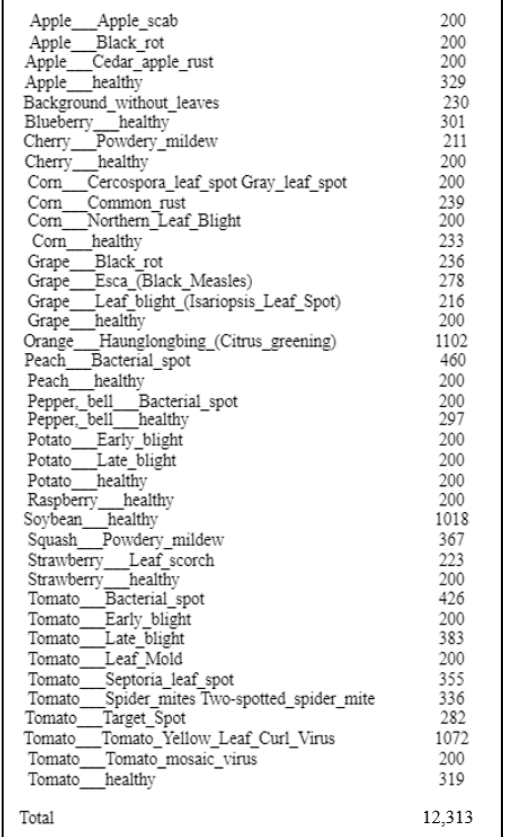
Figure 5. The dataset split for the testing subset of images, with the number of testing images used for each classification label (total 39 labels).